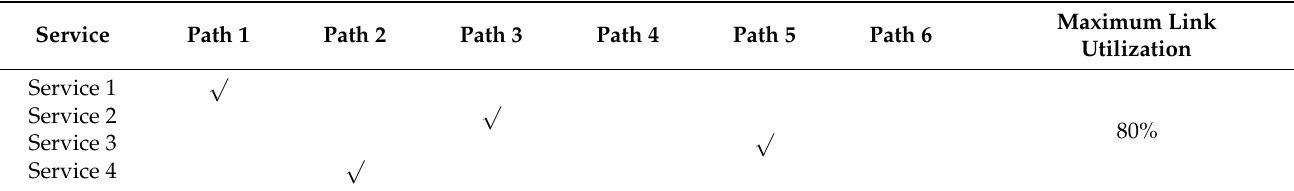
Table 5. Service status after path